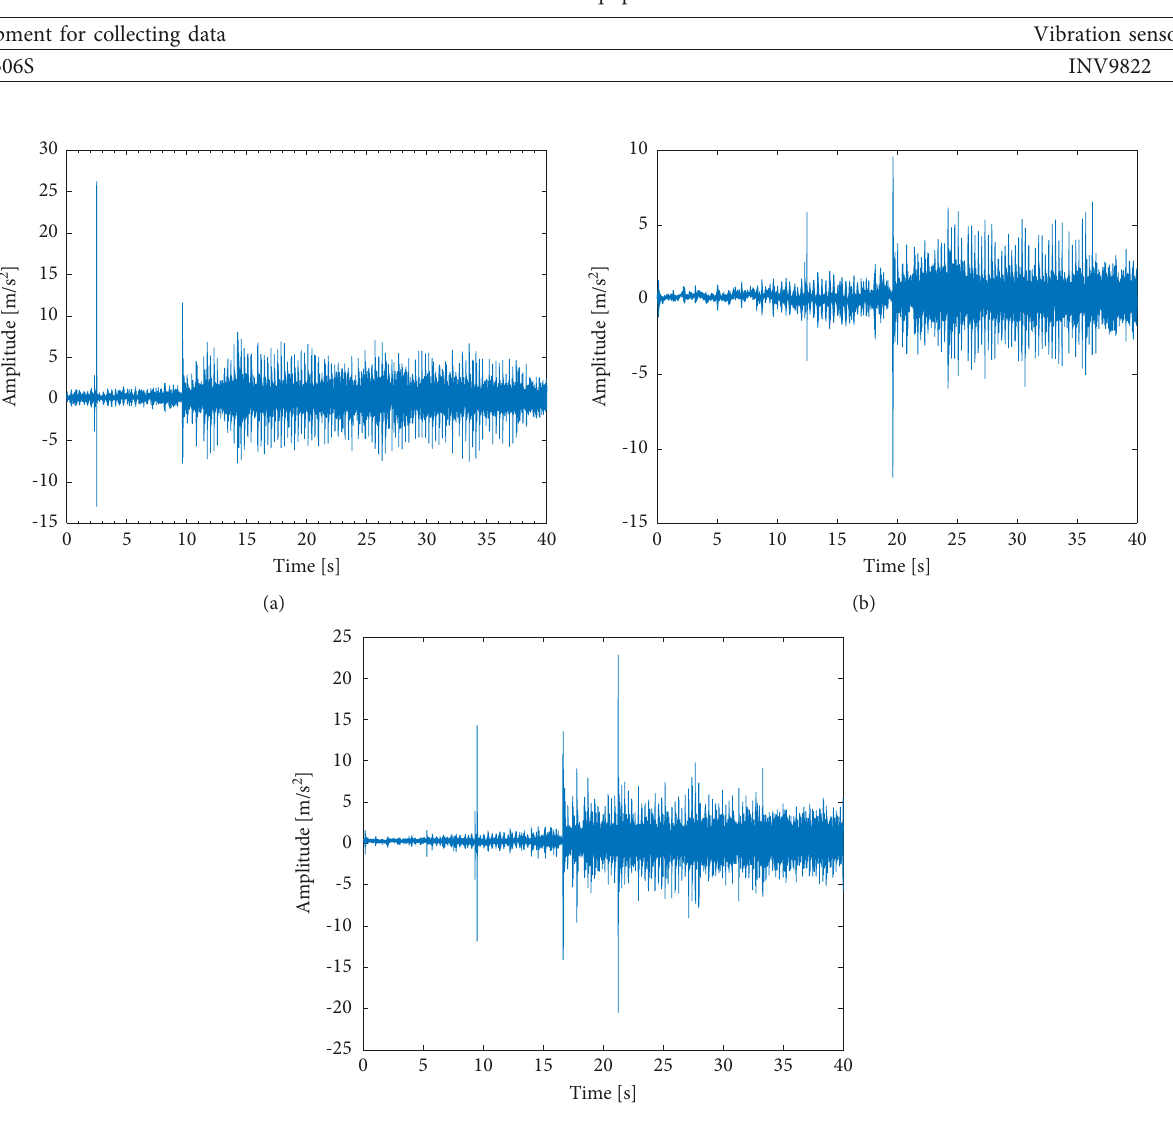
Figure 6: Diagram of data acquisition. Table 4: Test equipment.